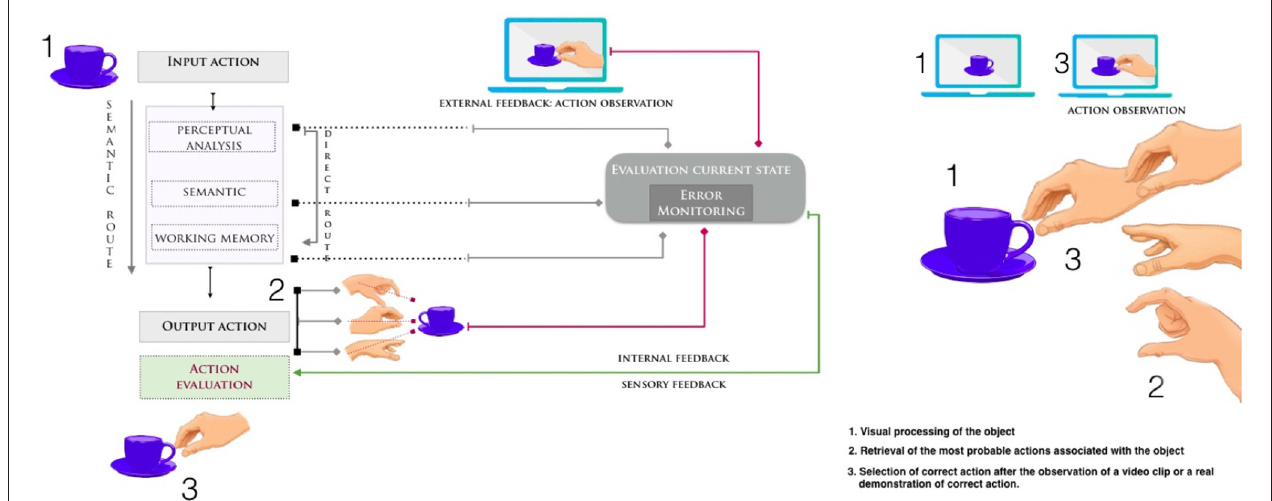
FIGURE 1 | Hypothetical model for performing and recognizing a transitive action [adapted from (54) and (55)]. Failures in performing or recognizing gestures may occur because of damage at any stage in the directional flow between perceiving (input) and performing (output) the action. The observation of a video clip or a real demonstration of action can have a positive effect on the selection and retrieval of the correct movement. In figure the example of grasping a cup of coffee. After the correct visual identification of the object as a cup, patients with apraxia have a difficult retrieval of the correct action associated with that object. When an incorrect movement is performed, a discrepancy occurs between the (correct) action observed on the model and the perception of own (incorrect) performed gesture. Combining motor training and action observation may enhance the relearning of daily actions and strengthen the visuo-motor